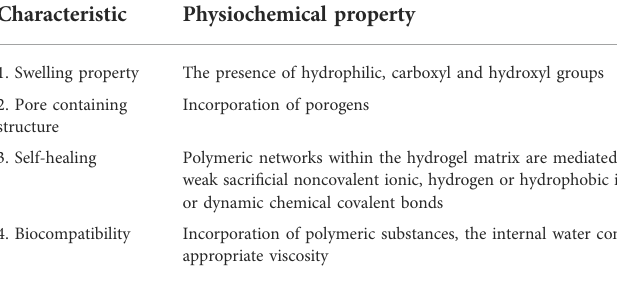
TABLE 1 The physiochemical properties of